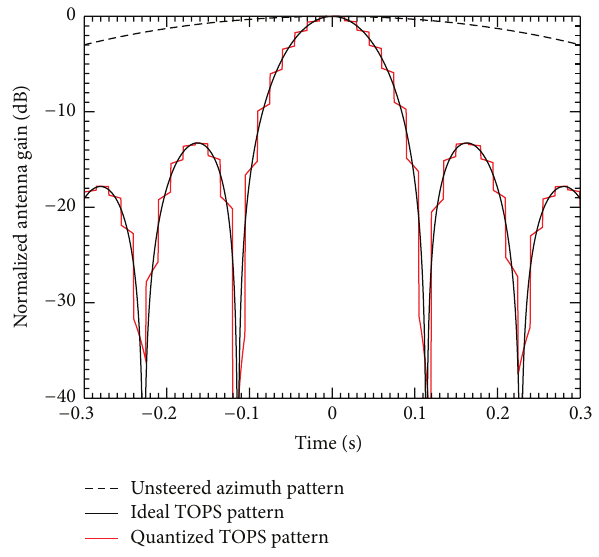
Figure 1: One-way azimuth antenna pattern gain in TSX TOPS mode as seen by a point target.